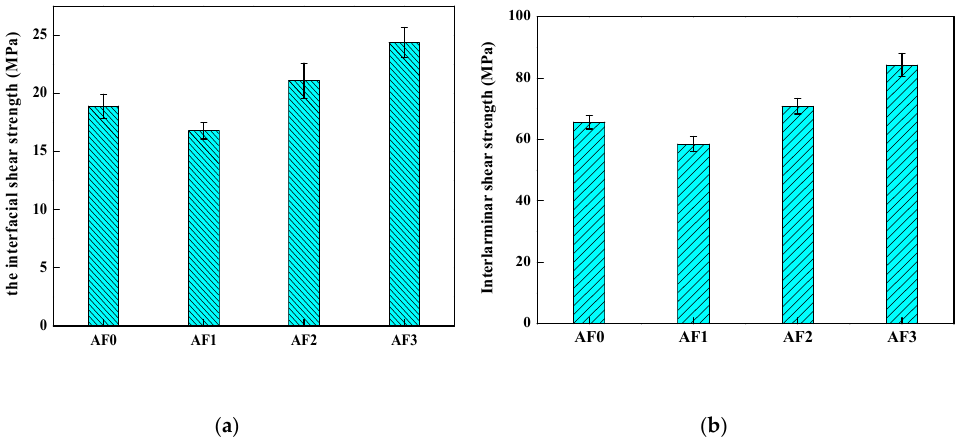
Figure 14. The mechanical performance of aramid fiber/epoxy with different processing. (( a ) the interfacial shear strength; ( b ) the interlaminar shear strength). Table 6. The interfacial shear strength (IFSS)/interlaminar shear strength (ILSS) value of different specimen.